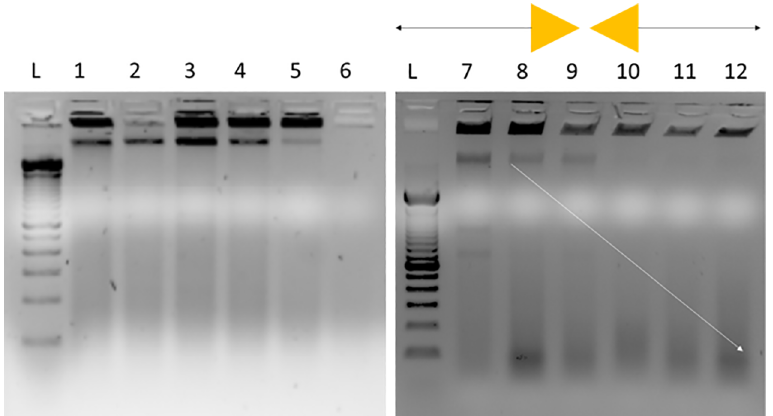
Fig 3. Microwave cellular lysis visualization through gel electrophoresis. Microwave cellular lysis of [10 8 cfu] V . cholerae at 30% power (270 watts), ( Left ) Standard microwave heating, ( Right ) Microwave heating with Lyse-It 1 . L: 100 bp ladder, 1: Pre V . cholerae microwave irradiation, 2–6: 15–75 seconds no Lyse-It 1 , 7: Pre V . cholerae microwave irradiation, 8–12:15–75 seconds Lyse-It 1